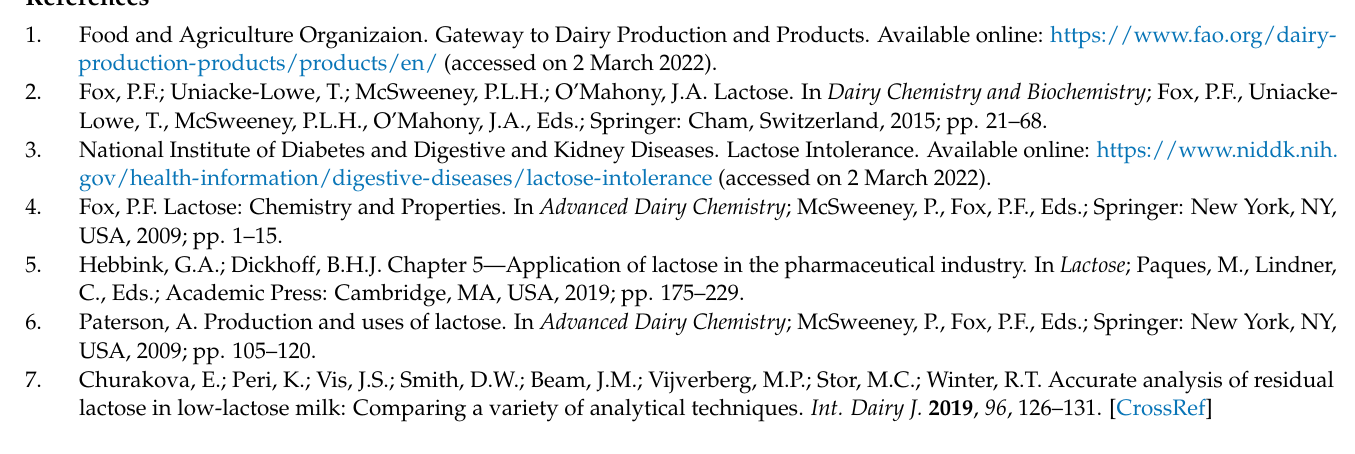
infant formula Sample 1; Figure S3: Product label of infant formula Sample 2; Figure S4: Product label of infant formula Sample 3; data and source